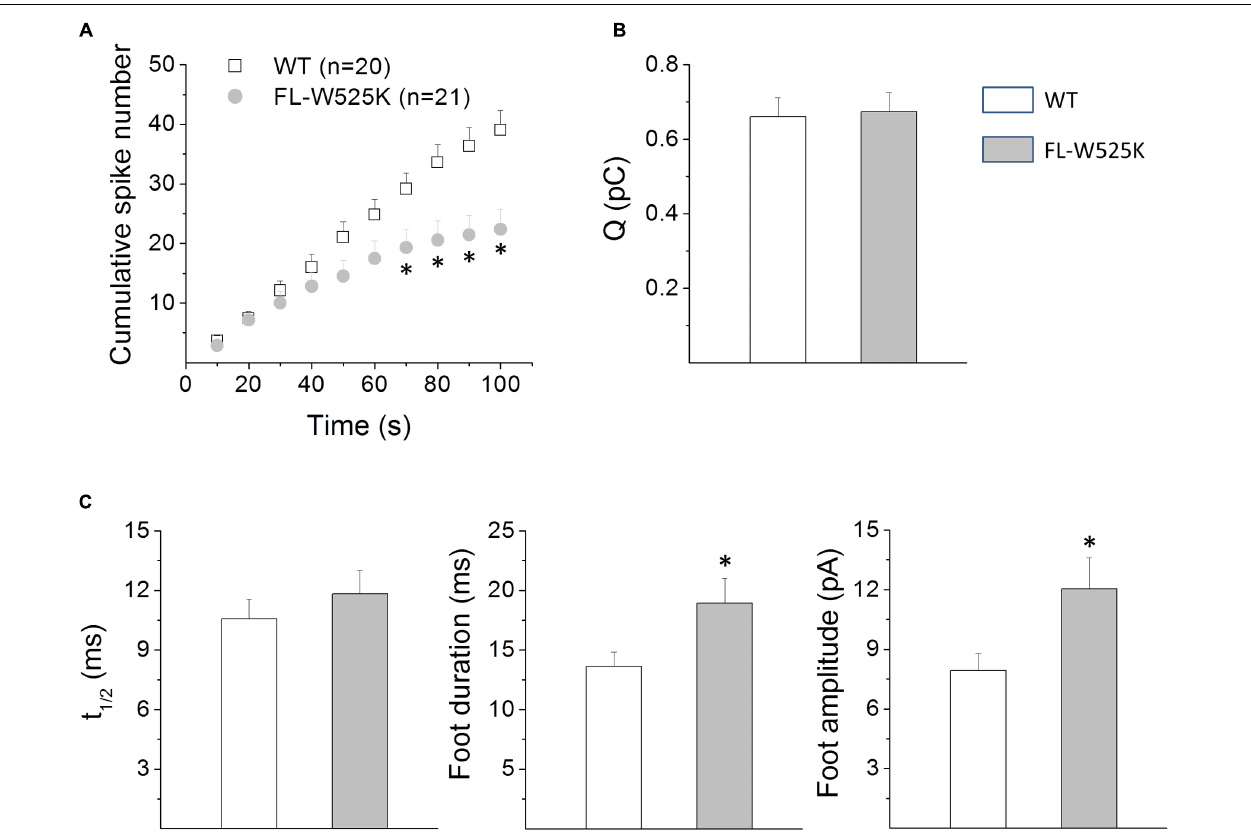
FIGURE 4 | Effects of the expression of the FL-W525K cortactin mutant on exocytosis in chromaffin cells. (A–C) Chromaffin cells were transfected with WT, or with the FL-W525K mutant deficient in binding PRD-containing proteins. The exocytosis response evoked by a 10 s pulse of 50 µ M DMPP was monitored by amperometry 48 h after transfection. Each amperometric recordings lasted 100 s. (A) Cumulative histograms of the number of amperometric spikes during the entire recording in cells transfected with WT cortactin or its FL-W525K mutant. Numbers between parentheses indicate the number of cells analyzed from at least three different cultures. Notice that the number of events is reduced in cells expressing FL-W525K compared to WT during the last 40 s of the recording. ∗ p < 0.05 (unpaired t -test). (B,C) Graphs represent the mean median values per single cell of the quantal size (Q), half width (t 1 / 2 ) foot duration and foot amplitude of amperometric spikes from cells expressing WT (white bars) or the FL-W525K cortactin mutant (gray bars). Data are means ± SEM. Numbers of cells for each condition are the same as indicated in (A) . ∗ p < 0.05 compared with WT (unpaired t -test).